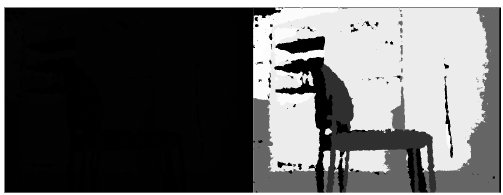
Figure 3. Image obtained from the kinect(left hand side) compared with equalized image (right hand side).